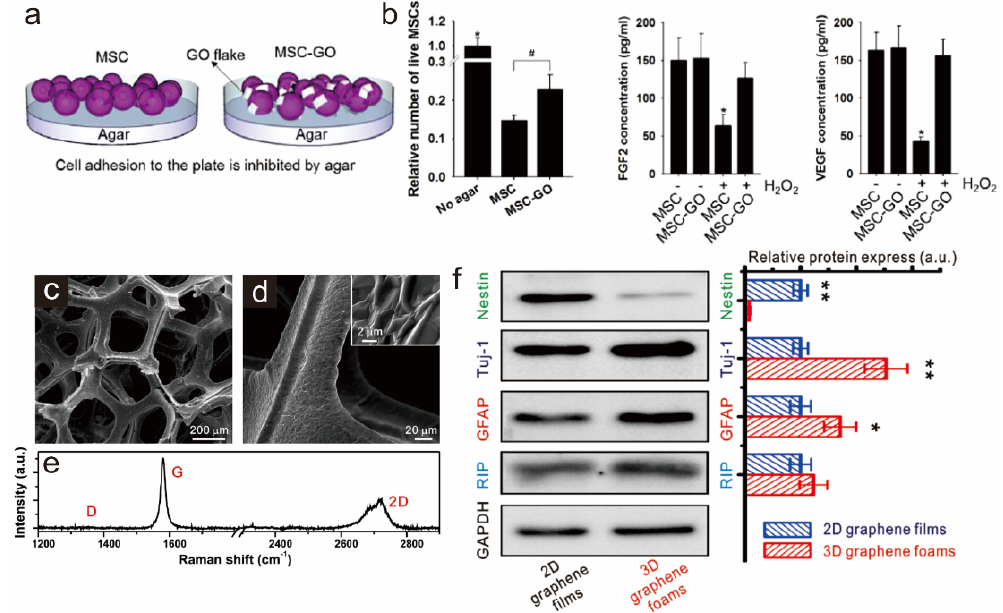
Figure 4. Protection of ROS ‐ mediated cell death via graphene oxide (GO). ( a ) Viability of mesenchymal stem cells (MSCs) cultured on an agar plate with or without GO addition. ( b ) Amounts of two different proteins (FGF2 and VEGF) secreted by MSCs and GO ‐ protected MSCs with or without hydrogen peroxide (H2O2). * p < 0.05 compared to any group; # p < 0.05; n = 3. Reprinted with permission from [49]. Copyright 2015 American Chemical Society. ( c – d ) SEM images of 3D graphene foams (3D ‐ GFs) and ( e ) its Raman spectrum. Enhanced differentiation of neural stem cells cultured